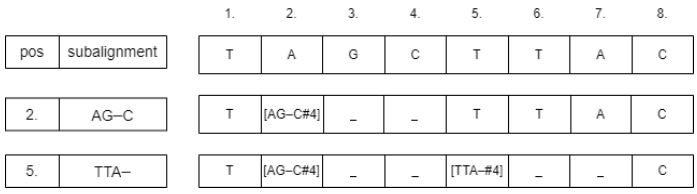
Figure 3. Example of inserting subalignments of length 4 into a sequence.